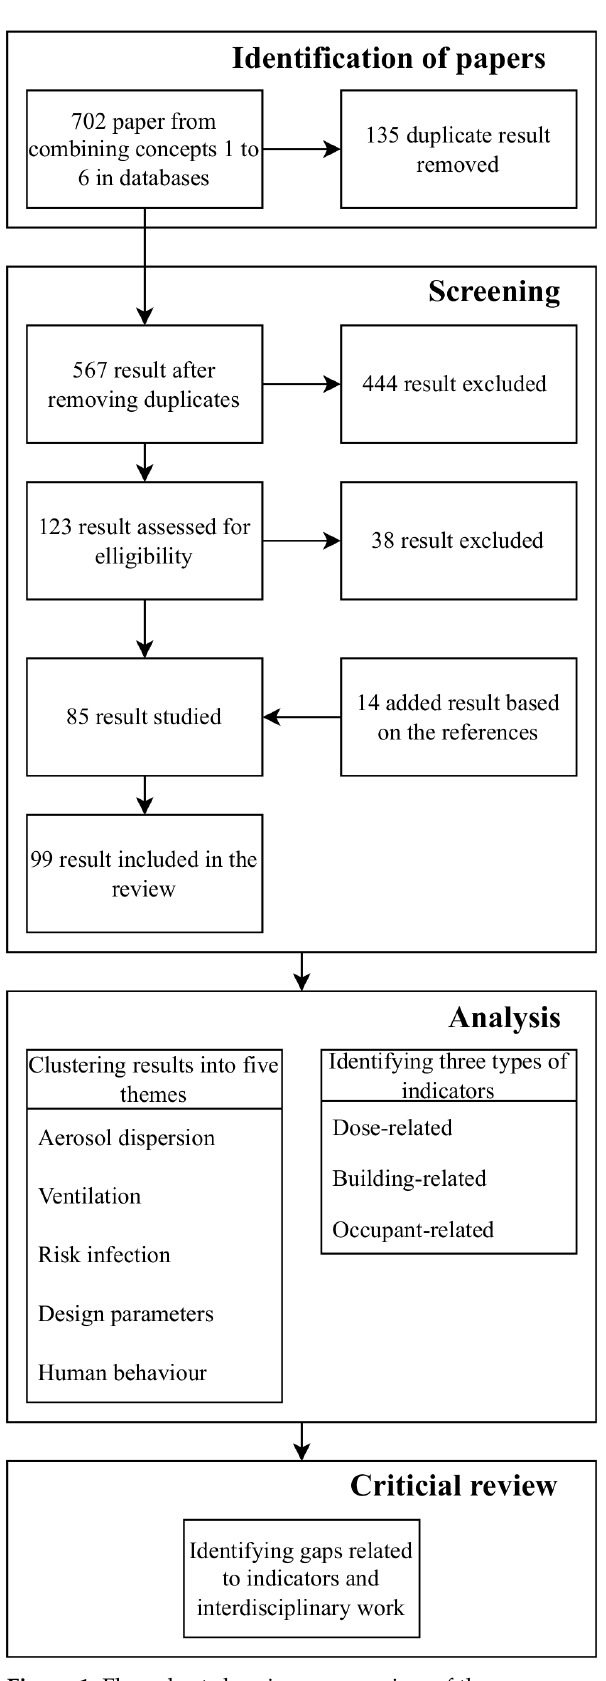
Figure 1. Flow chart showing an overview of the process used in this